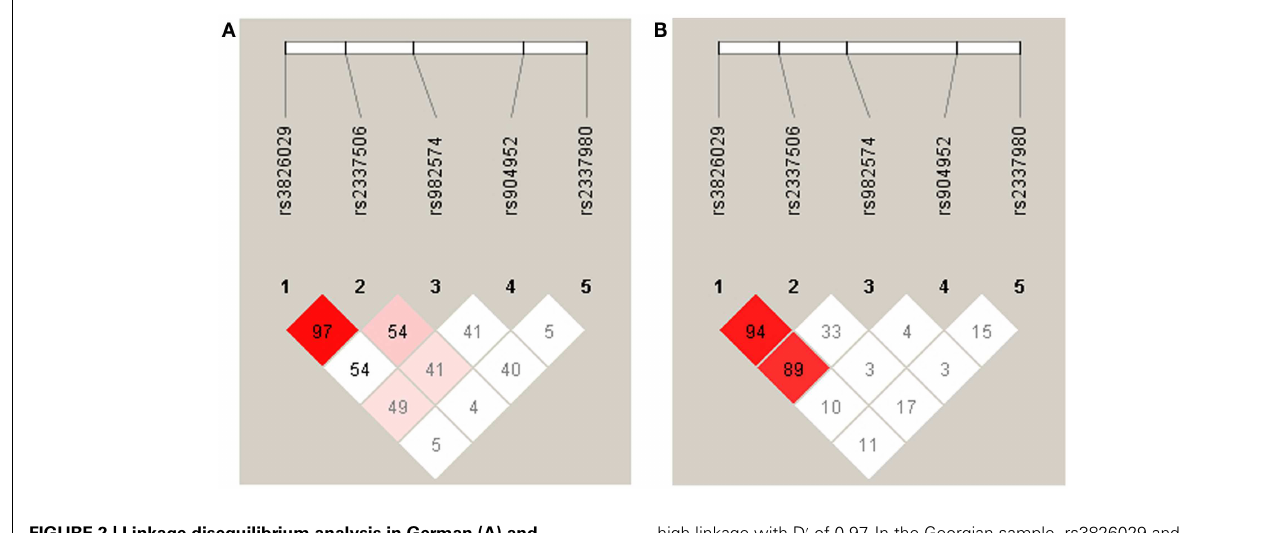
FIGURE 2 | Linkage disequilibrium analysis in German (A) and Georgian (B) samples .The strength of LD is determined as Lewontin’s D (cid:48) . In the German sample the SNPs rs3826029 and rs2337506 showed